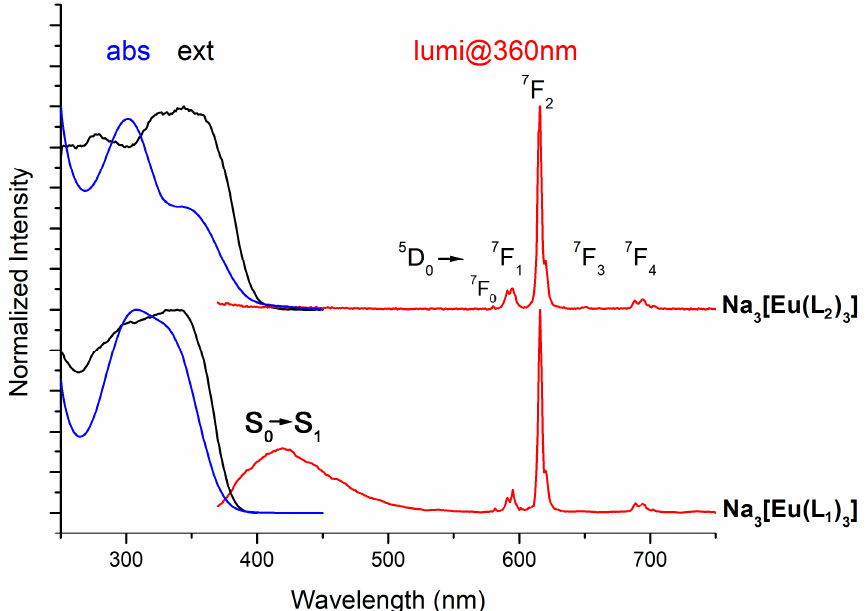
Figure 6. Luminescence (red) at 360 nm, excitation (black) and absorption (blue) of Na 3 [Eu(L 1 ) 3 ] (below) and Na 3 [Eu(L 2 ) 3 ] (above) complexes in water solution.